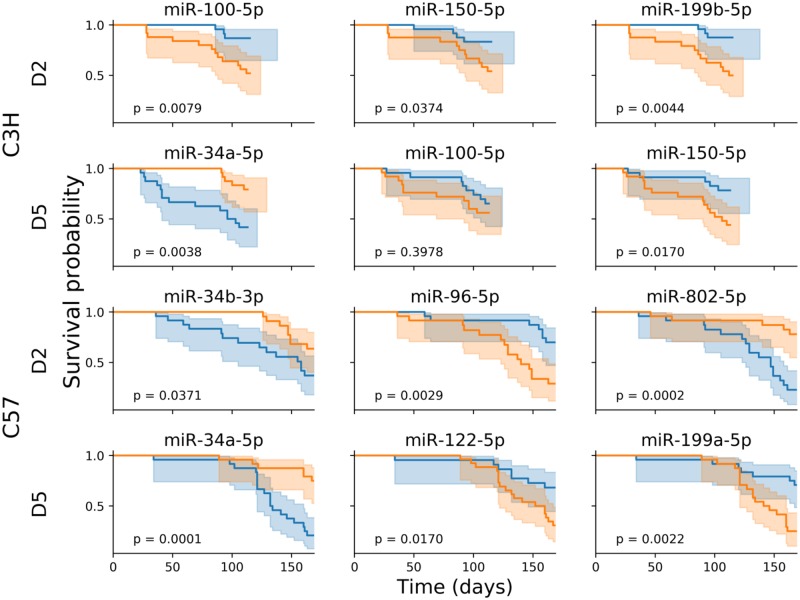
Differences in survival probability for mice with miRNA expression above or below the median abundance.For each strain and time point, key miRNA in a Cox proportional hazard model were identified. Mice were divided into two cohorts based on expression above (blue) or below (orange) the median abundance. In most cases, the difference in survival between these two cohorts was statistically significant (log rank test), suggesting a role for these miRNAs as potential biomarkers for early identification of late organ injury following exposure to ionizing radiation.